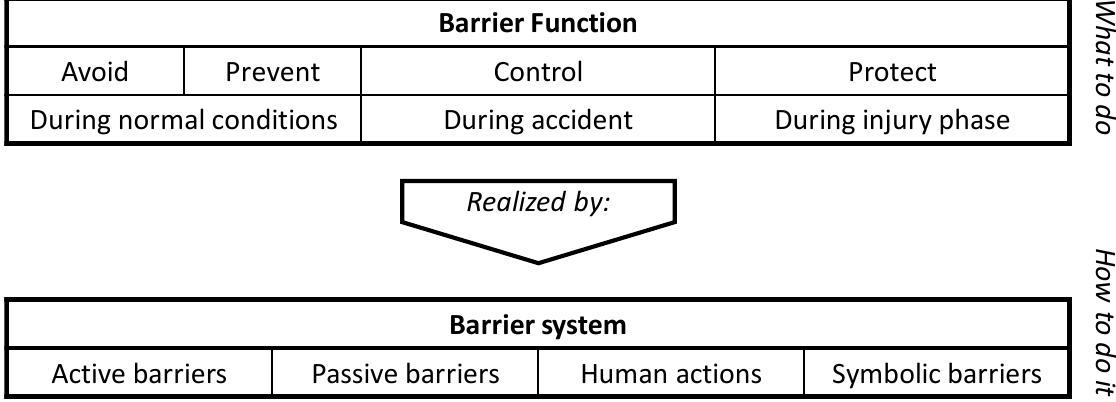
Figure 2. Classification of barrier functions and barrier systems.